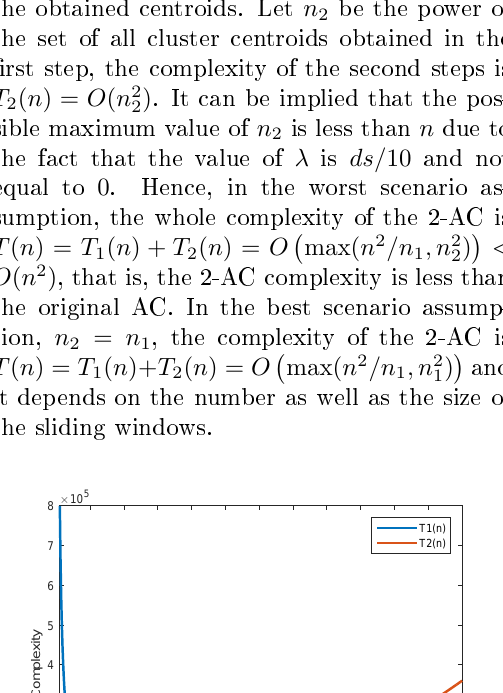
Tab. 1: Some of common standard digital image sizes and the approximate optimal window sizes